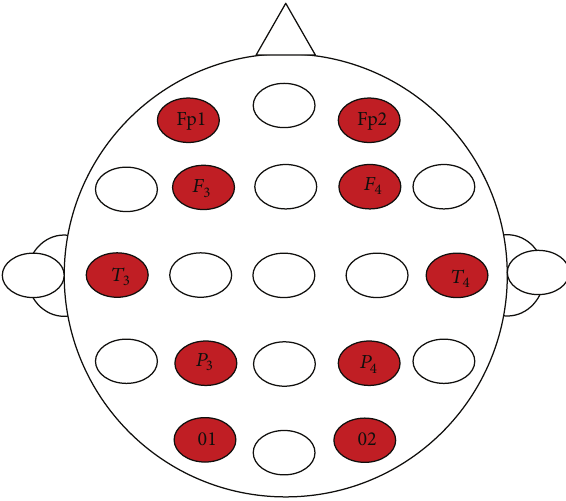
Figure 2: Electrodes in the 10–20 systems that were actually